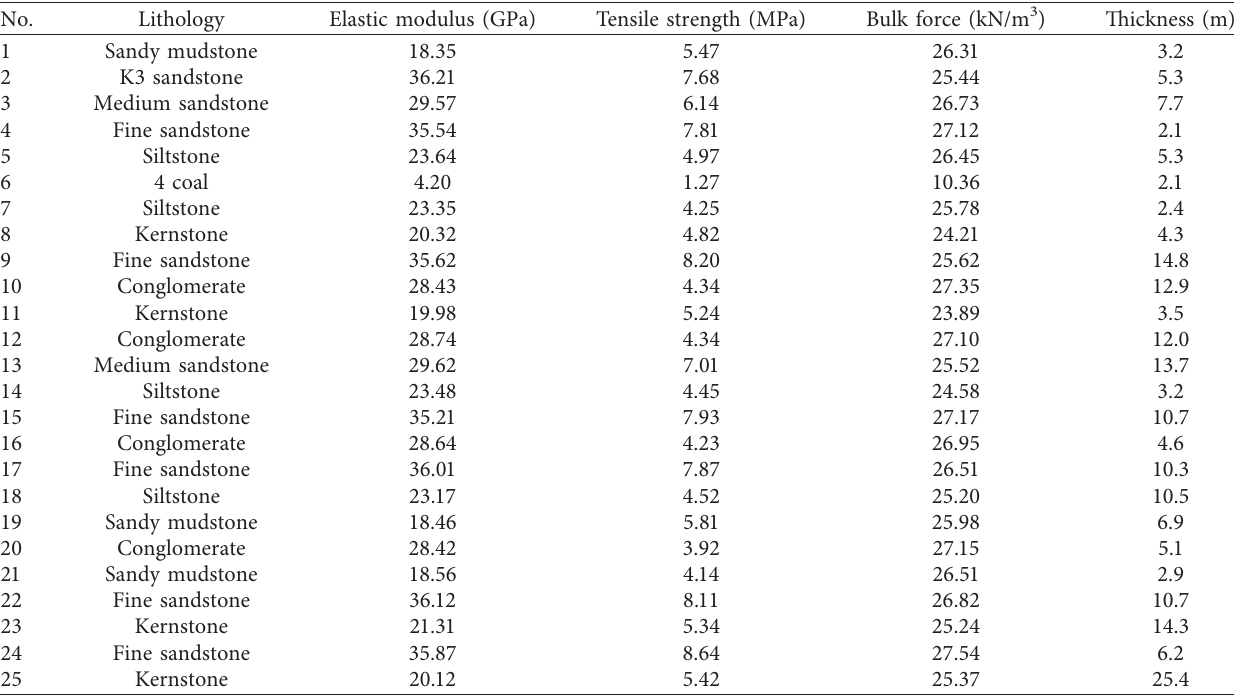
Table 1: Characteristics of overlying